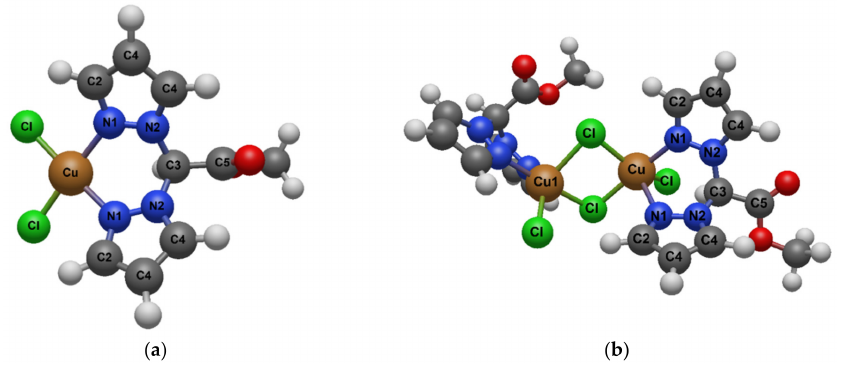
Figure 6. DFT models of the local atomic structure around Cu in complex 5 with both monomer ( a ) and dimer ( b ) configuration. For sake of XAFS data analysis, the dimer configuration was obtained by adding the Cu 1 neighbor. Neighbor atoms are labeled to be individuated in the shell structure reported in Table